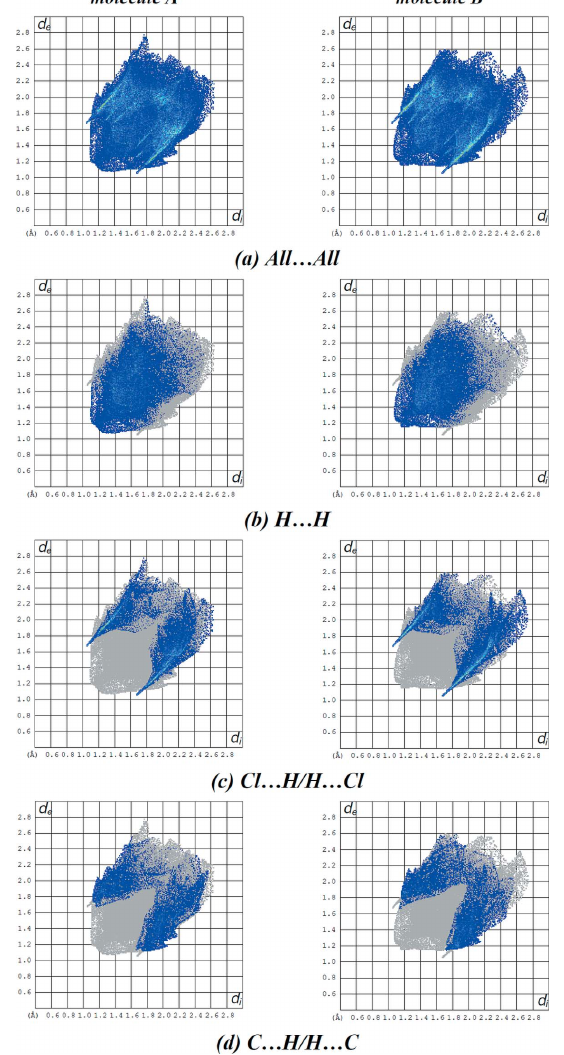
Figure 6 The full two-dimensional fingerprint plots for both molecules A and B showing ( a ) all interactions, and delineated into ( b ) H (cid:2)(cid:2)(cid:2) H, ( c ) Cl (cid:2)(cid:2)(cid:2) H/ H (cid:2)(cid:2)(cid:2) Cl and ( d ) C (cid:2)(cid:2)(cid:2) H/H (cid:2)(cid:2)(cid:2) C interactions. The d i and d e values are the closest internal and external distances (in A˚ ) from given points on the Hirshfeld surface.